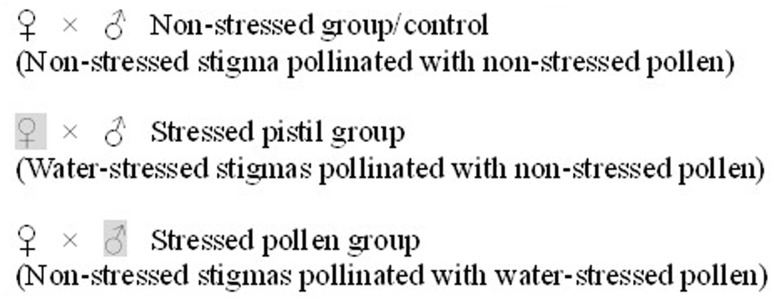
List of treatment groups and crosses performed. Water-stressed female and male parts are shaded in gray.